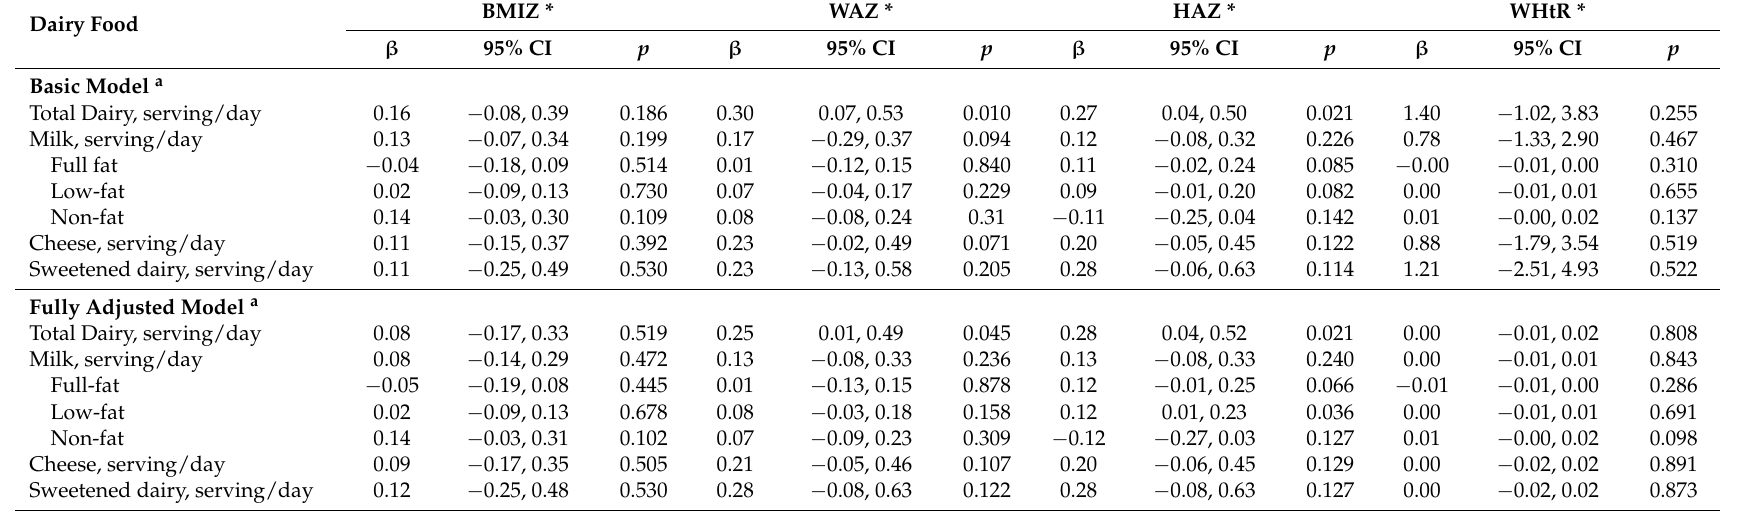
Table 3. Associations * between types of dairy foods and anthropometric indicators of growth (in z-scores) and central